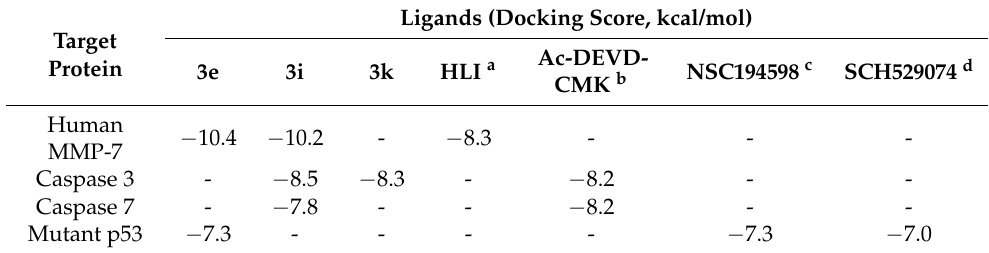
Table 1. Best binding energy (kcal/mol) based on AutoDock scoring of the hybrids 3e, 3i and 3k against multiples molecular targets.